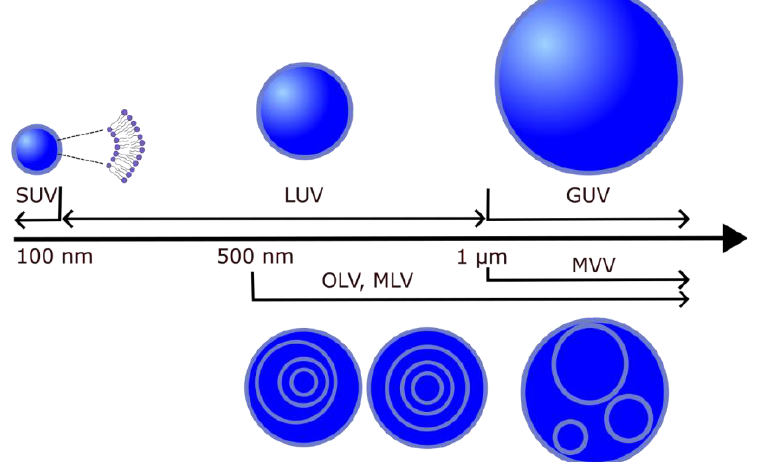
Figure 3. Different types of lipid vesicles depending on their size and structure.